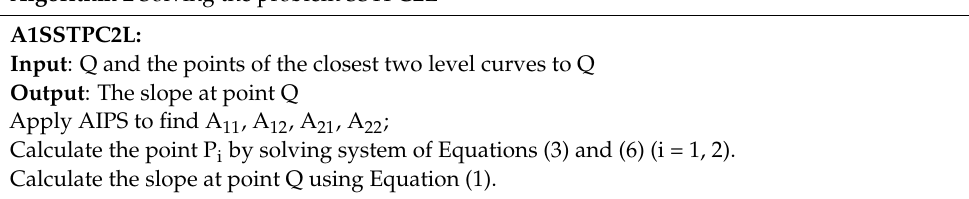
Algorithm 2 Solving the problem